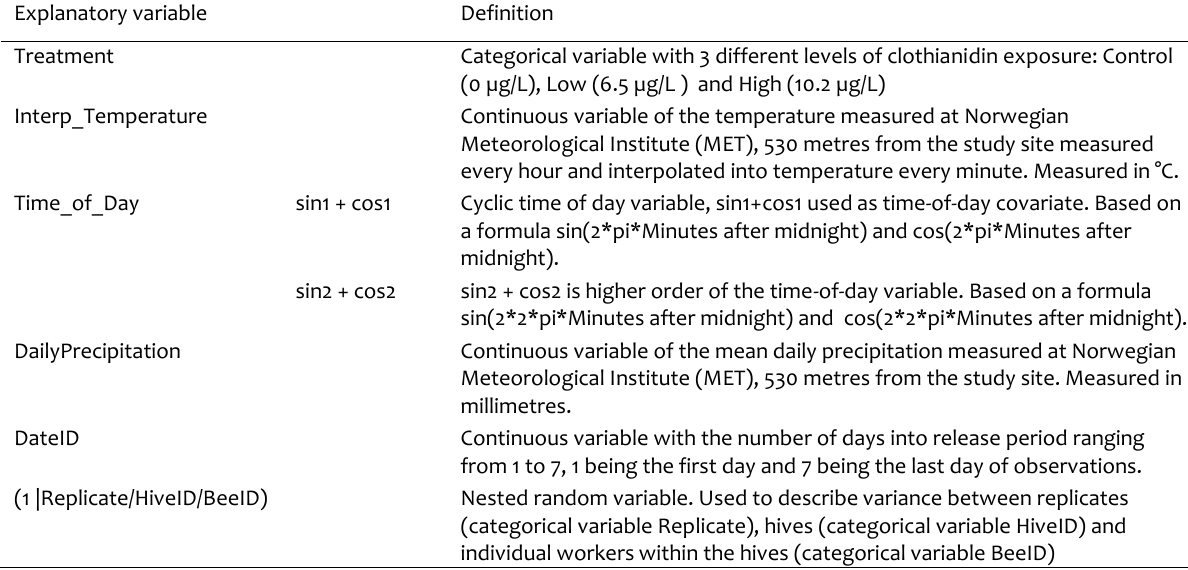
Table I. Overview of the explanatory variables used in the GLMM explaining the changes to foraging bout duration. Explanatory variable Definition Treatment Categorical variable with 3 different levels of clothianidin exposure: Control Continuous variable of the temperature measured at Norwegian